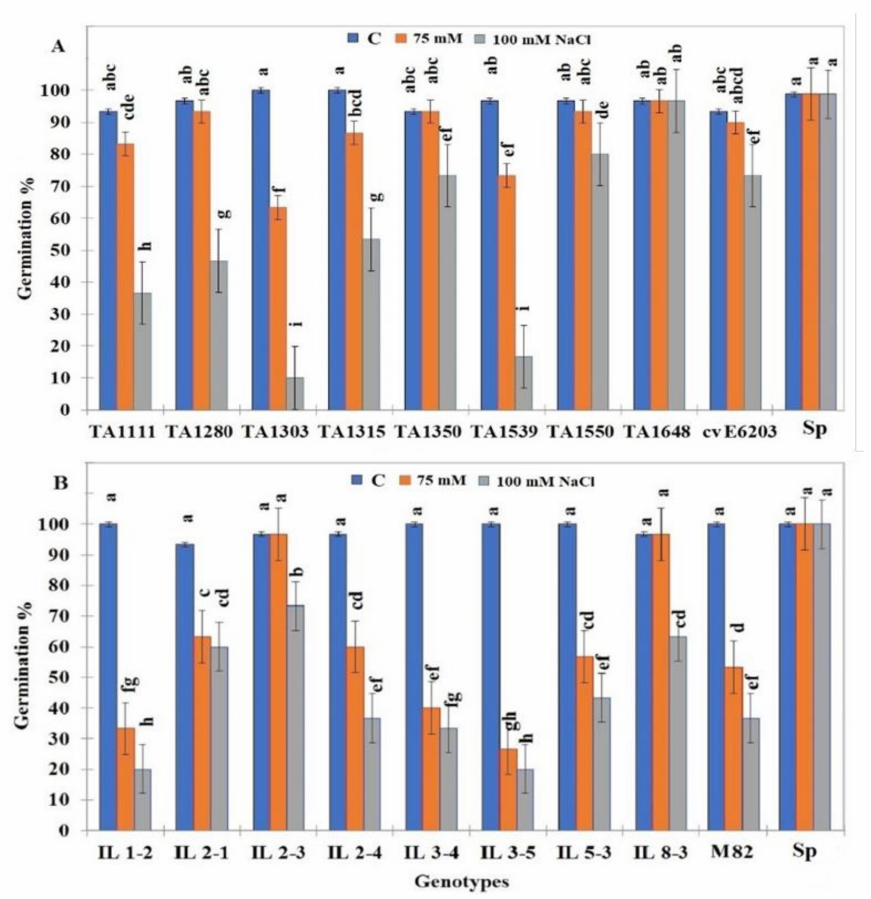
Figure 1. The percentage of germination of tomato ILs seeds under control (0 mM NaCl) and salt stress conditions (75 mM and 100 mM NaCl). ( A ) ILs from group I ( S. lycopersicum cv-6203 × S. habrochaites ). ( B ) ILs from group II ( S. lycopersicum cv-M-82 × S. pennellii ). Data are means of three replicates ± standard deviation; different letters on bars represent significant values according to Duncan’s test ( p <